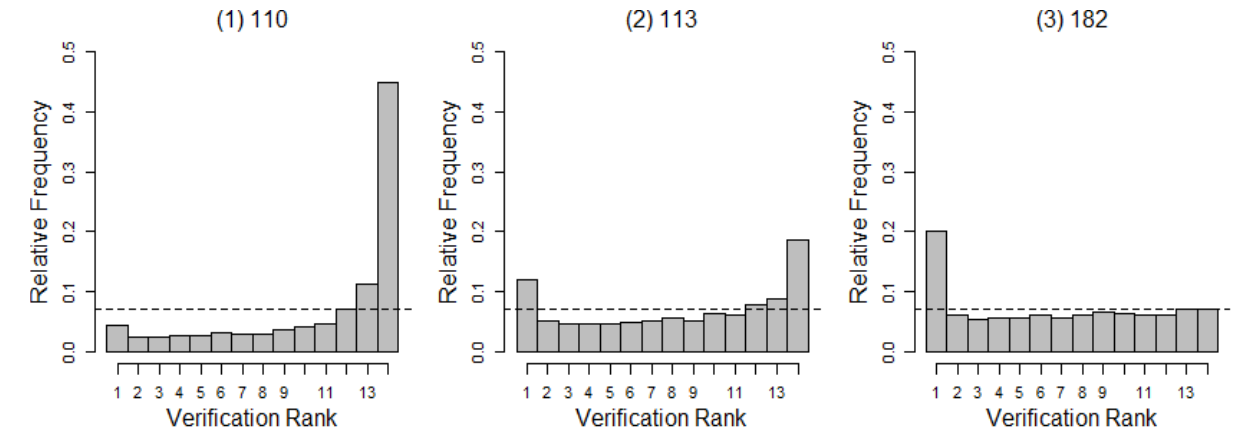
Figure 2. Verification rank histograms for (1) Station 110, (2) Station 113, and (3) Station 182. The reliability index [31] was used to quantify the deviation of the rank distribution from uniformity. The reliability index (RI) is defined as K ∑ RI =